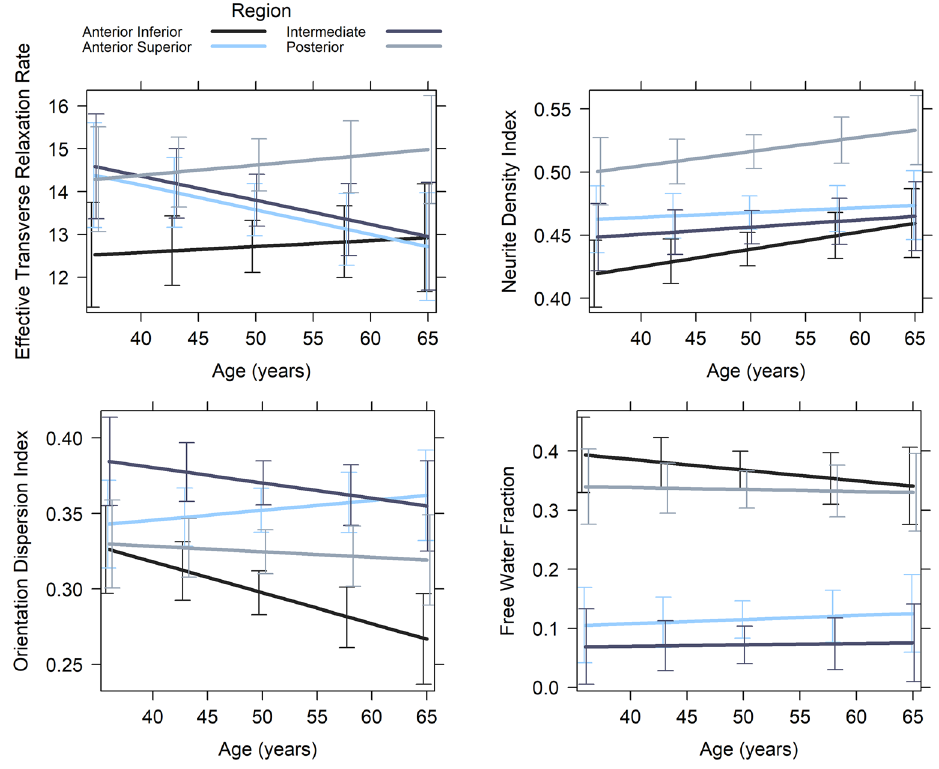
Figure 1. Hypothalamic microstructure across subunits in association with age investigated with linear mixed effects models. Error bars depict the 95% confidence interval.